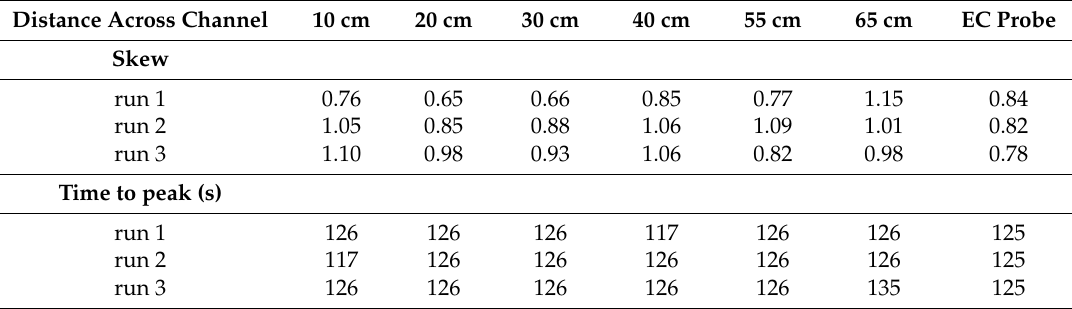
Figure 4. Neerigen Brook Reach 1. Cross-section tracer curves. Legend shows distance across channel transect and mid-channel EC data. Table 2. Neerigen Brook Reach 1. Tracer results for skewness and time to peak. Distance Across